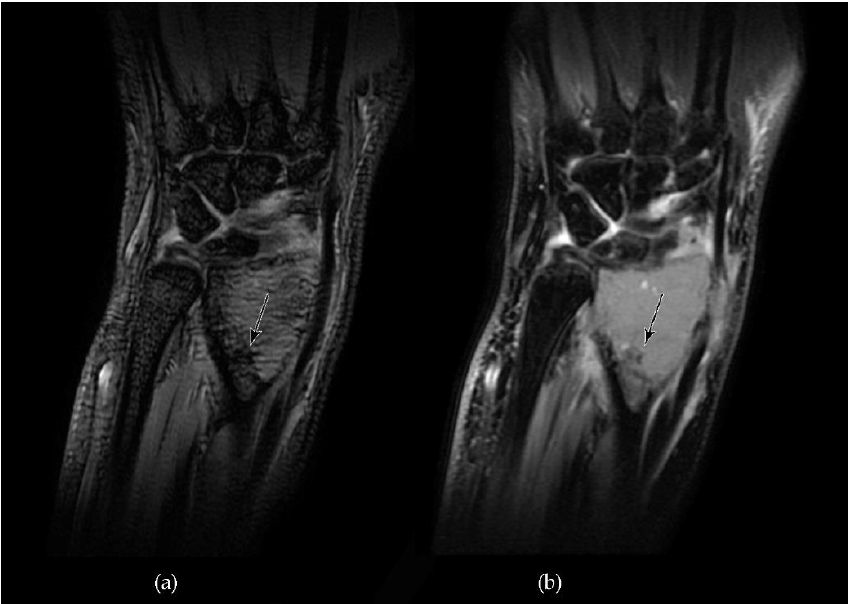
Figure 3. MRI appearance of hemosiderin deposits (arrows) in a case of GCTB of the left radial metaepiphysis ( a ). T2*-W GRE sequence demonstrates a markedly and distinctly hypointense area that appears more tenuously hypointense in a T2-W Fast Spin Echo (FSE) sequence ( b ).